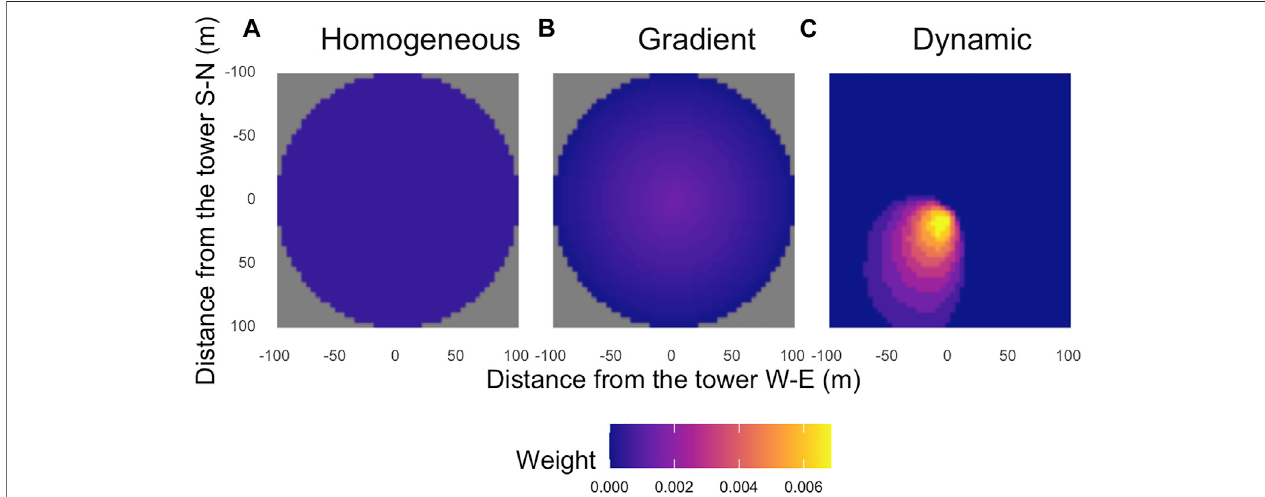
FIGURE2| Sourceareaandweightdistributionfordifferentfootprintalgorithmswithinanareaof200 m×200 mandtheECtowerasthecenter(50latitudegrids× 50 longitude grids): (A) the “ homogeneous ” footprint (HF) algorithm regards each grid cell contributes evenly to total EC fl ux, (B) the “ gradient ” footprint (GF) algorithm regardsthe contribution ofgrid cells gradually decrease from the center to edge; and (C) the “ dynamic ” footprint (DF) algorithm considers theenvironmental in fl uence to generate dynamic EC footprints at daily time step. Figure (A) and (B) are constant throughout the year. Figure (C) shows a sample of EC footprints produced for ATQ on 22 September 2013. Grey indicates the data are unavailable. Relative weights are shown and the weights for all grids within the entire domain sum to one.